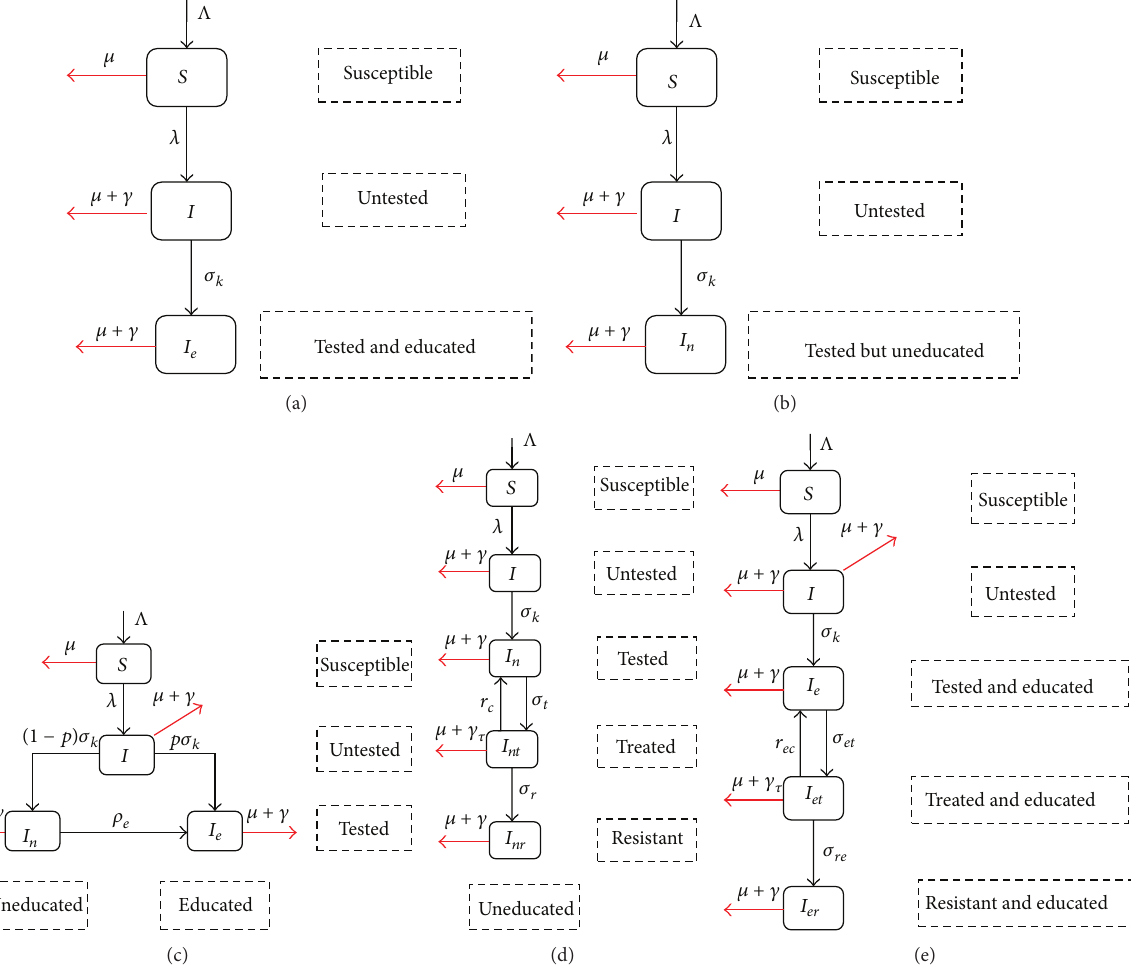
Figure 2: The five submodels. (a) Testing with obligatory education. (b) Testing only. (c) Test and treat with limited education. (d) Test and treat with drug resistance. (e) Test and treat with drug resistance and obligatory